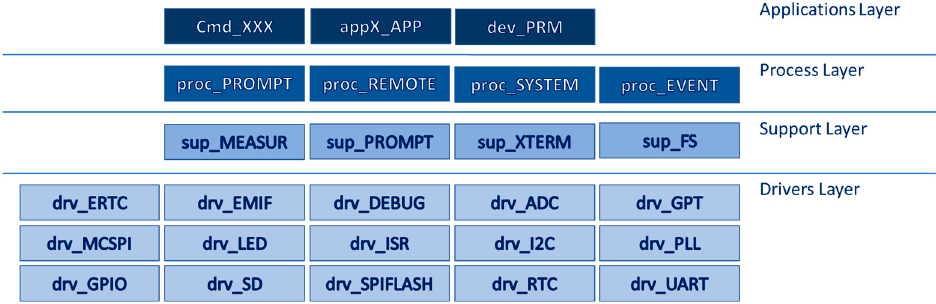
Figure 3. Layered architecture of the DSP module firmware.